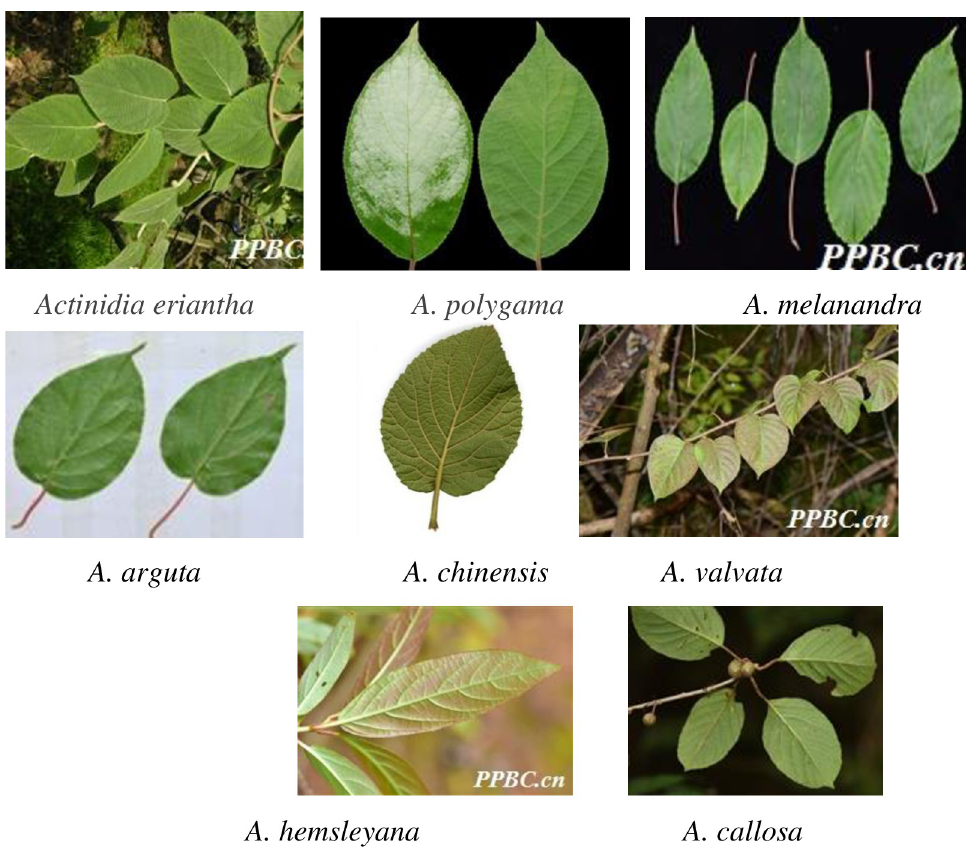
Fig 1. Leaf image of 8 species of Actinidia . Note: All pictures from Plant Photo Bank of China.